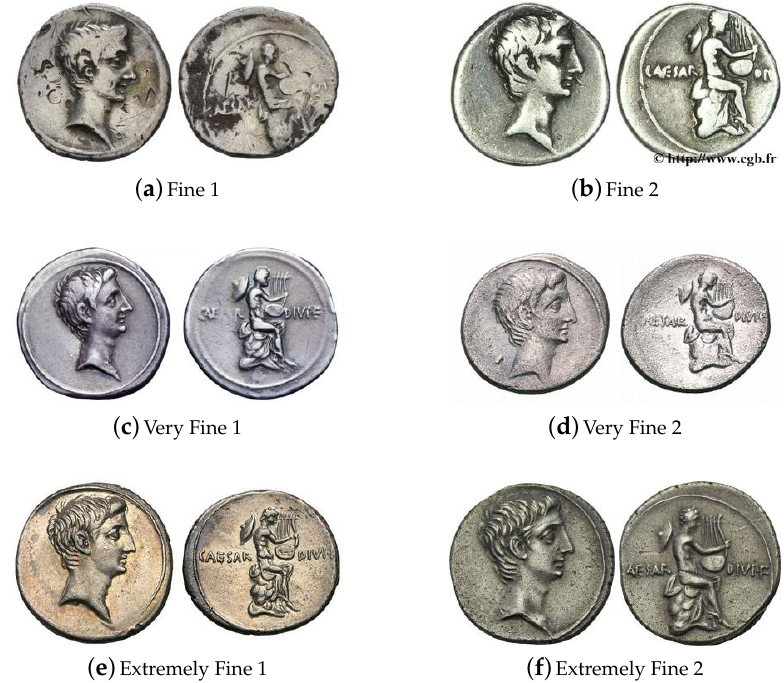
Figure 9. Our data set entry for Octavian Augustus Denarius RIC 257—there are images of two specimens for each of the three conditions included for all denarii issues in the data set (F, VF, and XF).